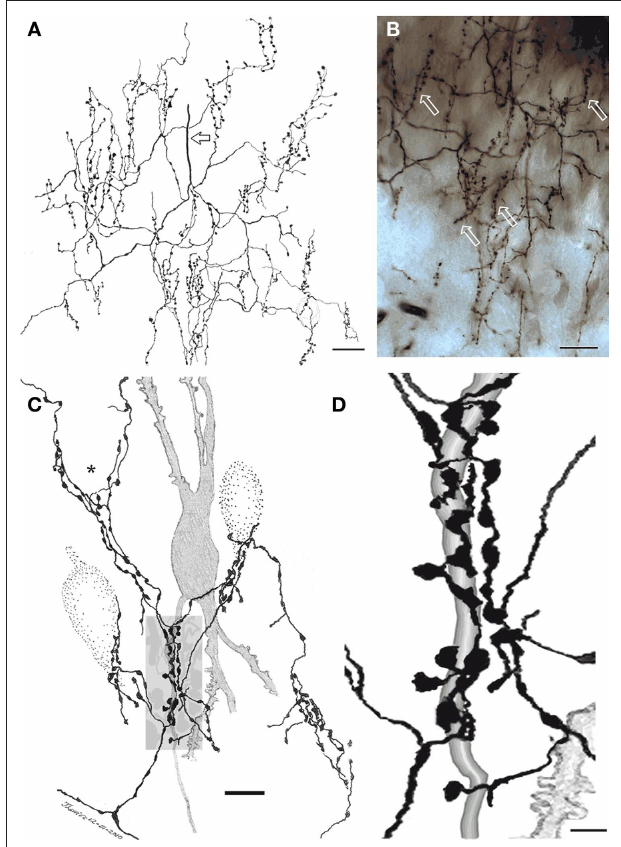
Figure 4 | Chandelier cell axon (A) Camera lucida drawing of the proximal part of a chandelier cell axon. Parent axon (hollow arrow) gives rise to several secondary branches that, in turn, resolve into vertically oriented candlesticks. (B) Survey photomontage showing the proximal axon and candlesticks (arrows) from a chandelier cell. (C) Interaction of terminal fibrils and candlesticks with the initial segment of an impregnated pyramidal cell axon (shaded) and those initial segments and soma from three putative pyramidal cells (dotted). Note that some fibrils ascend providing varicosities to the somatic area (asterisk). (D) Enlargement of the candle shaded in (B) . Rapid-Golgi technique, adult mouse brain. Scale bar = 10 μm in (A,B) , 5 in (C)